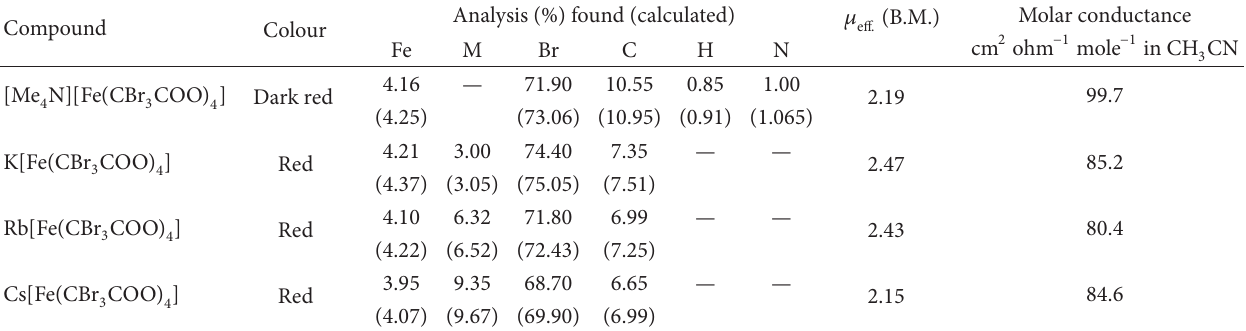
T 6: Amount, color, analysis, magnetic moments and molar conductance of